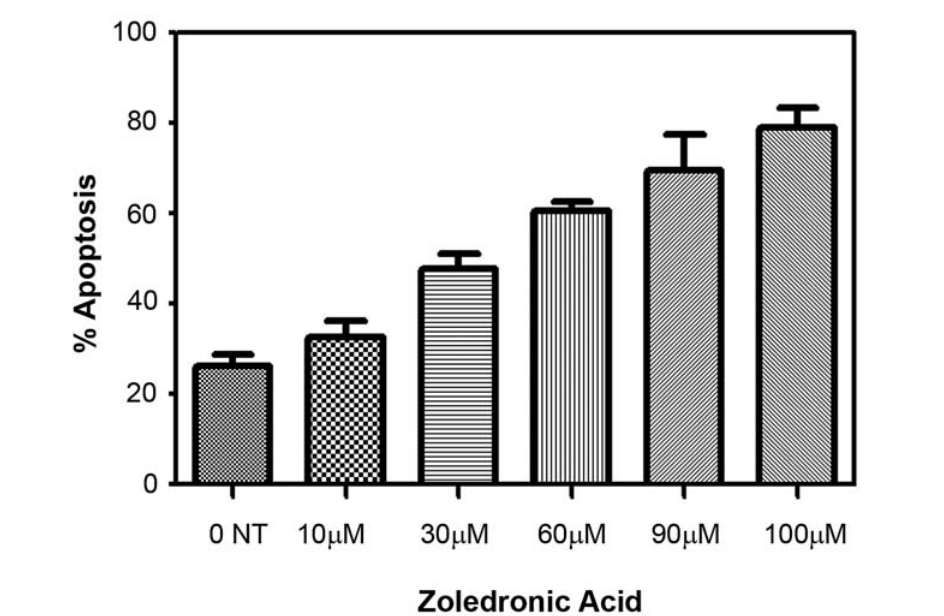
Figure 1 – Concentration dependent relative apoptosis in PC-3 cell line following exposure to zoledronic acid. PC-3 cell line was treated with increasing concentrations of zoledronic acid for 72 hours and then the levels of mono-oligo nucleosome fragments was (cid:84)(cid:88)(cid:68)(cid:81)(cid:87)(cid:76)(cid:191)(cid:72)(cid:71)(cid:3)(cid:88)(cid:86)(cid:76)(cid:81)(cid:74)(cid:3)(cid:38)(cid:72)(cid:79)(cid:79)(cid:3)(cid:39)(cid:72)(cid:68)(cid:87)(cid:75)(cid:3)(cid:39)(cid:72)(cid:87)(cid:72)(cid:70)(cid:87)(cid:76)(cid:82)(cid:81)(cid:3)(cid:46)(cid:76)(cid:87)(cid:17)(cid:3)(cid:38)(cid:82)(cid:79)(cid:88)(cid:80)(cid:81)(cid:86)(cid:15)(cid:3)(cid:87)(cid:75)(cid:72)(cid:3)(cid:80)(cid:72)(cid:68)(cid:81)(cid:86)(cid:3)(cid:82)(cid:73)(cid:3)(cid:87)(cid:90)(cid:82)(cid:3)(cid:76)(cid:81)(cid:71)(cid:72)(cid:83)(cid:72)(cid:81)(cid:71)(cid:72)(cid:81)(cid:87)(cid:3)(cid:72)(cid:91)(cid:83)(cid:72)(cid:85)(cid:76)(cid:80)(cid:72)(cid:81)(cid:87)(cid:86)(cid:30)(cid:3)(cid:69)(cid:68)(cid:85)(cid:86)(cid:15)(cid:3)(cid:54)(cid:39)(cid:17)(cid:3)(cid:19)(cid:3)(cid:49)(cid:55)(cid:15)(cid:3)(cid:88)(cid:81)(cid:87)(cid:85)(cid:72)(cid:68)(cid:87)(cid:72)(cid:71)(cid:3)(cid:70)(cid:82)(cid:81)(cid:87)(cid:85)(cid:82)(cid:79)(cid:86)(cid:17)(cid:3) (cid:51)(cid:3)(cid:31)(cid:3)(cid:19)(cid:17)(cid:19)(cid:24)(cid:15)(cid:3)(cid:89)(cid:86)(cid:17)(cid:3)(cid:70)(cid:82)(cid:81)(cid:87)(cid:85)(cid:82)(cid:79)(cid:86)(cid:17)